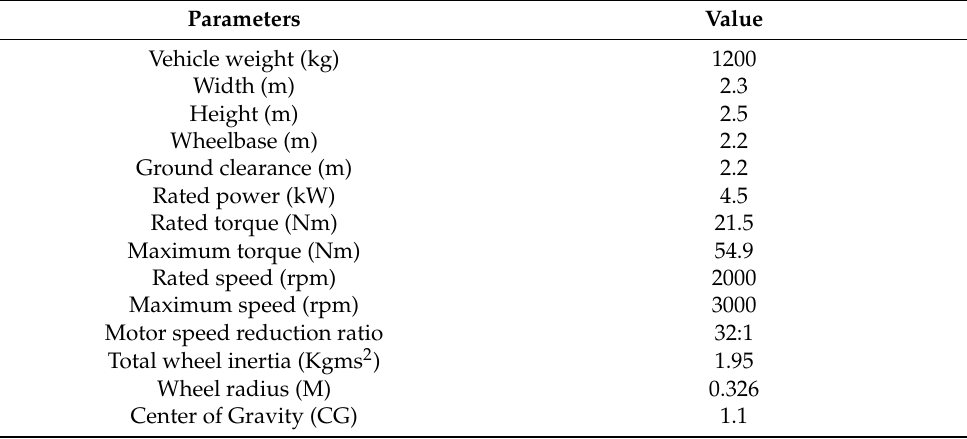
Table 2. Parameters of the vehicle’s major components.